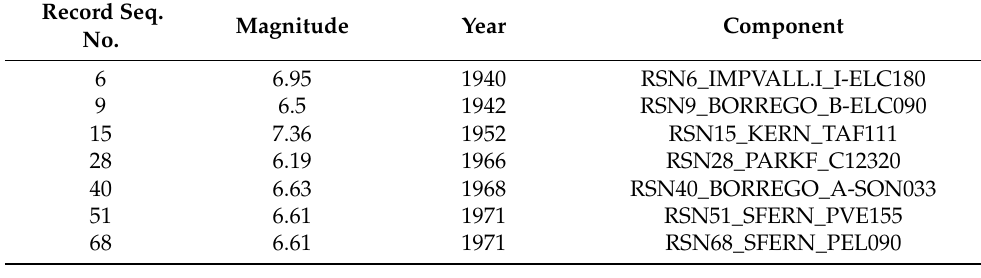
Table 3. Information about selected motions.